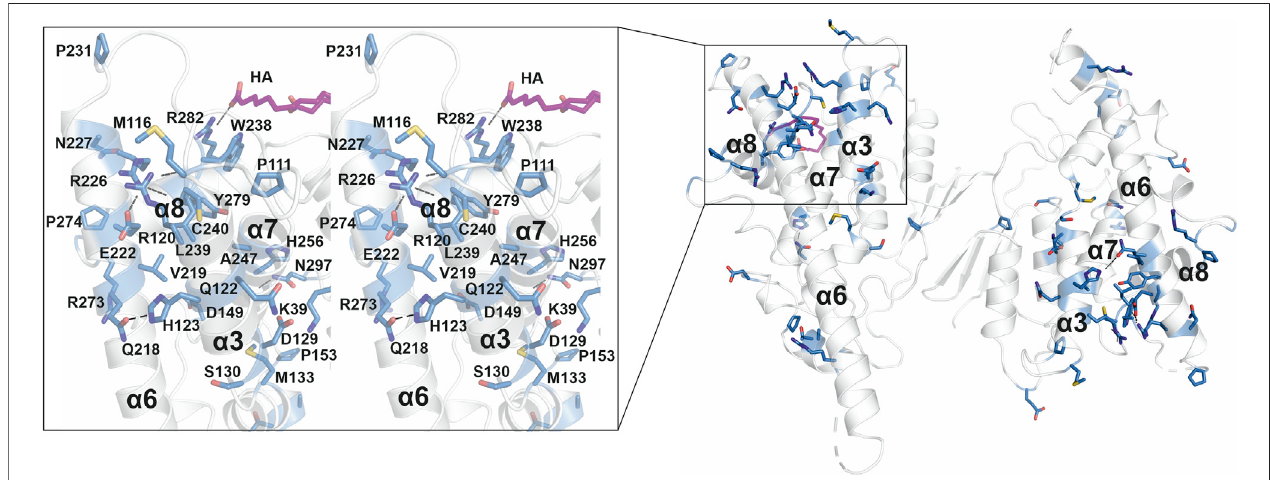
FIGURE 8 | CMT-related residue cluster. Close-up stereo view of the CMT-related residue cluster (sticks) and HA binding site. Hydrogen bonds are shown as dashed lines. HA is shown in